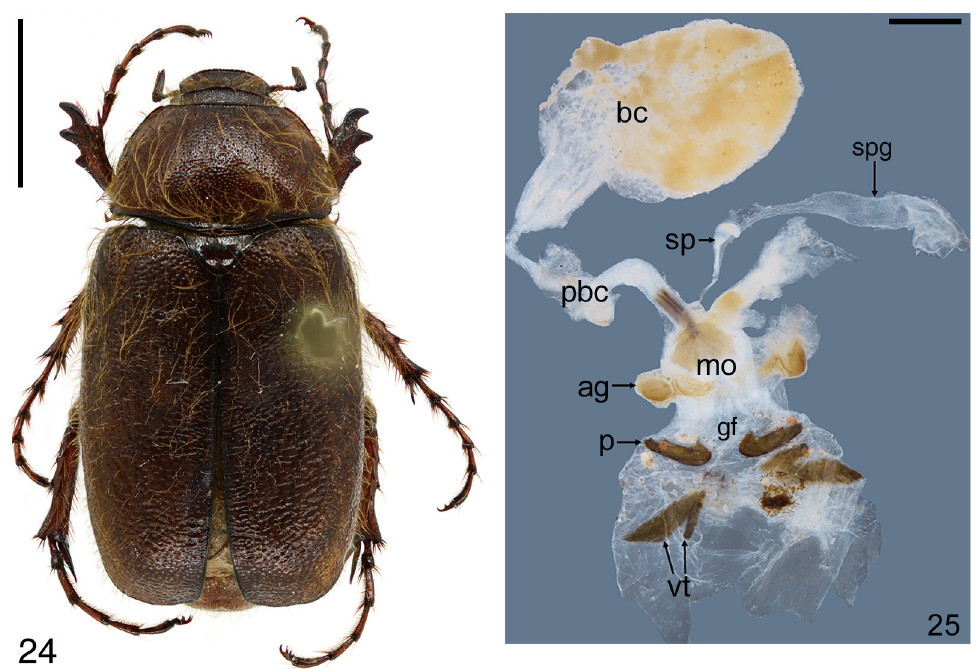
25 . Female genitalia in ventral view, non-type (SYAU). Scale bars: 24 = 5.0 mm; 25 = 1.0